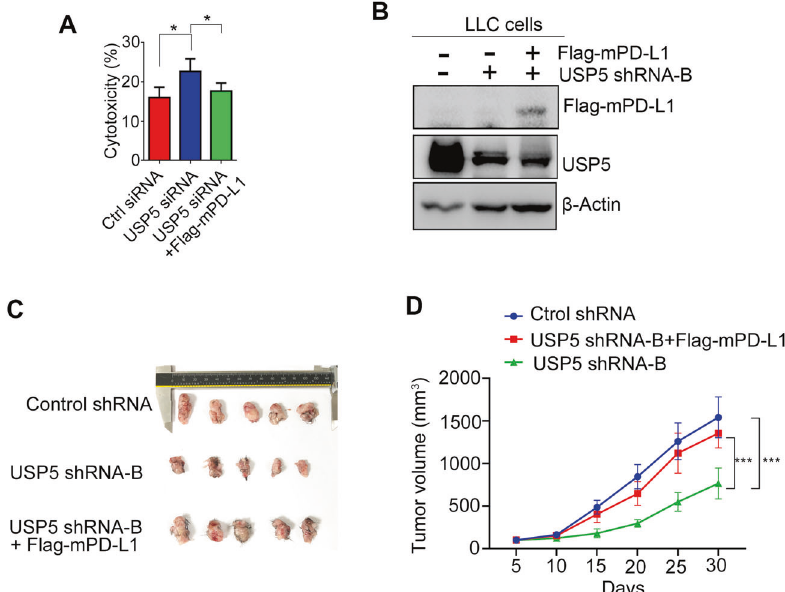
Fig. 5 Ectopic expression of mouse PD-L1 (mPD-L1) could reverse USP5 knockdown induced tumor growth inhibition. A T-cell killing assay of LLC cells transfected with indicated USP5 siRNA or mouse Flag-PD-L1 (Flag-mPD-L1) was performed to as described in “ Methods ” section, and the cytotoxicity was evaluated by LDH release assay using the culture supernatant. B Western blot analysis of USP5 and PD-L1 expression in LLC cells transfected with indicated constructs. LLC cells expressing control, USP5 shRNA or USP5 shRNA plus Flag-mPD-L1 were implanted into right fl ank of C57BL6 mice. C Tumor image and tumor growth curve ( D ) was shown. * P < 0.05 and *** P < 0.001 by two-tailed t